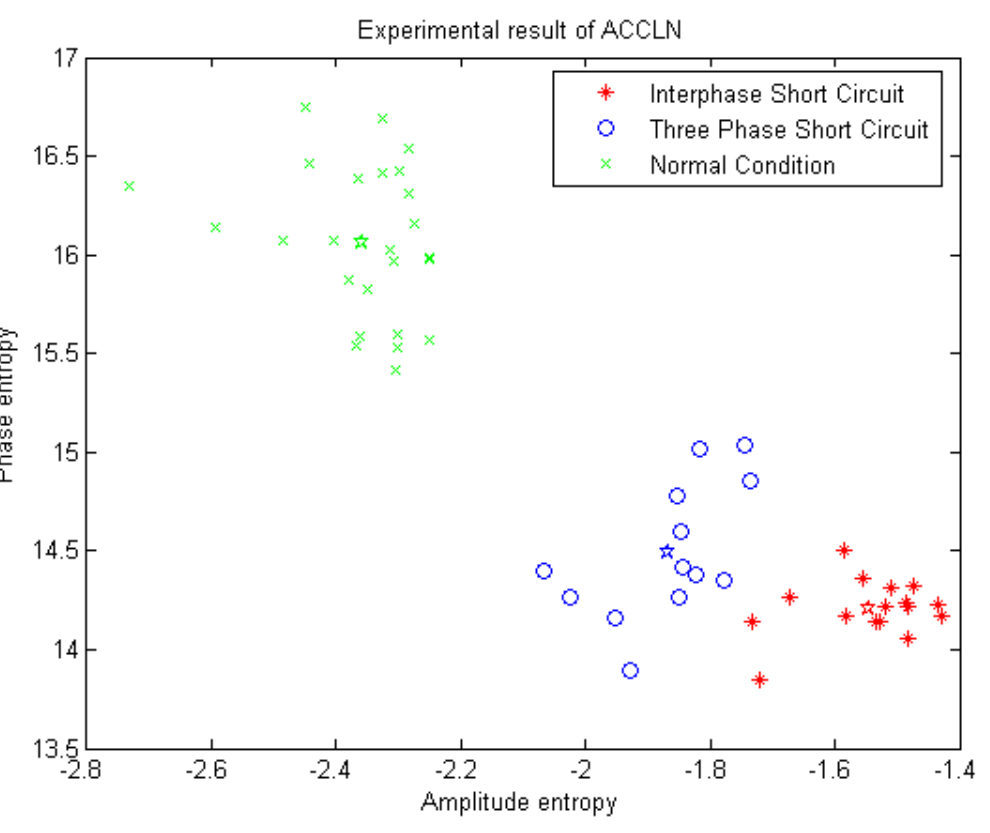
Figure 11. Experimental result of ACCLN. X axis indicates amplitude entropy; Y axis indicates phase entropy.